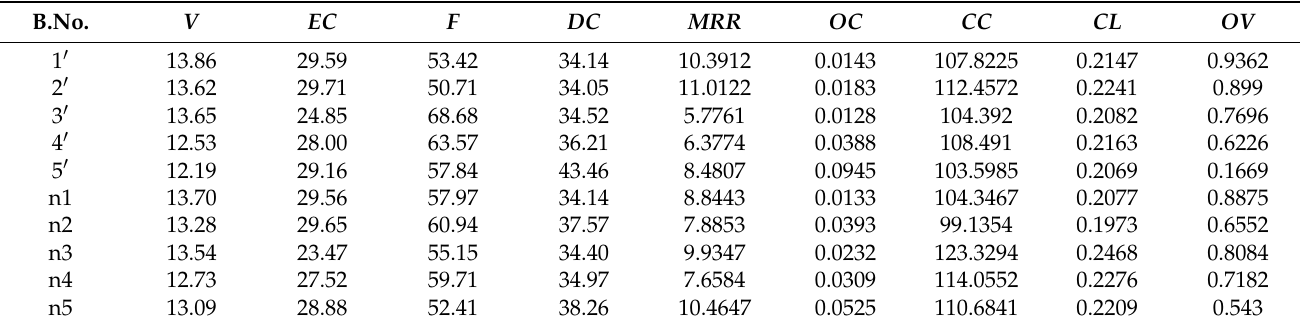
Table A9. New single objective values.